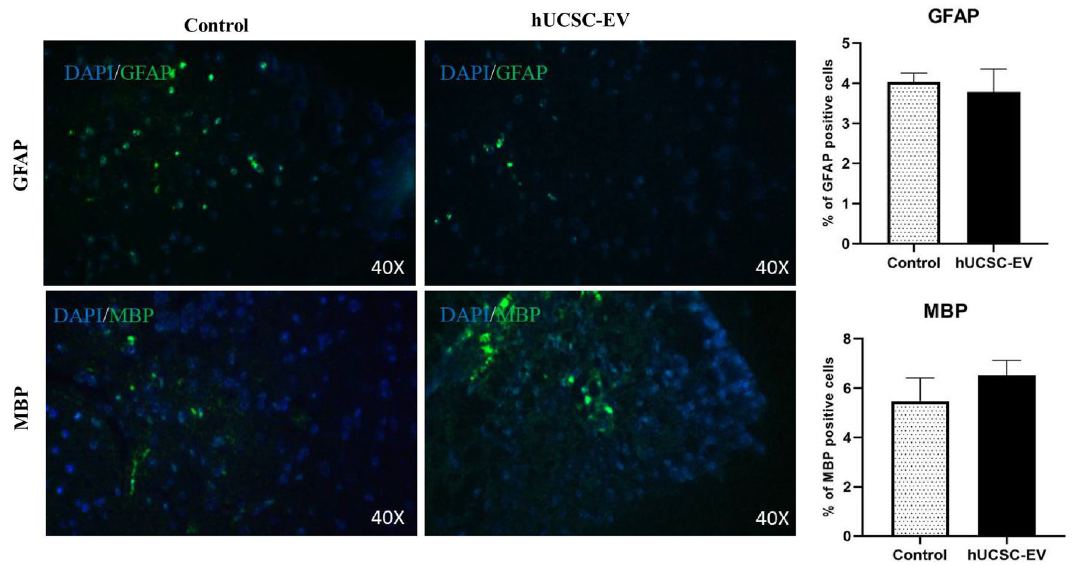
Figure 7. Immunofluorescence of repair-associated markers. There was no significant difference in the percent of positive MBP and GFAP cells between the untreated control and hUCSC-EV-treated groups by immunofluorescence. Data are shown as mean ± SD. GFAP glial fibrillary acidic protein, MBP myelin basic protein, MFI mean fluorescence intensity, hUCSC-extracellular vesicle human umbilical cord-derived mesenchymal stem cell-extracellular vesicle.